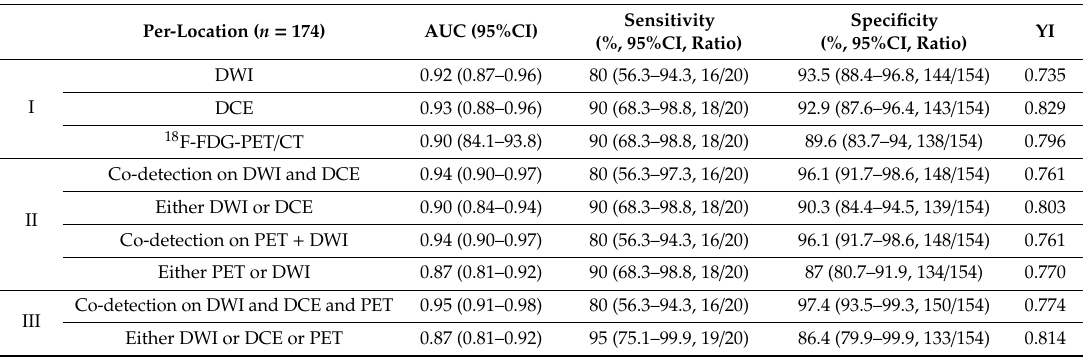
Table 3. The per-location diagnostic accuracy of (I) single use of DWI, DCE or 18 F-FDG-PET / CT and (II) the combined use of DWI + DCE and separately PET + DWI; of which the first line comprised a co-detection on both imaging modalities rated positively for malignancy. The second line comprised an independent detection on DWI or DCE and separately PET + DWI, in which either one was rated positively. (III) The combination of DWI + DCE + PET; in which the first line comprised a co-detection on all DWI + DCE + PET rated positively for malignancy. The second line comprised an independent detection on DWI, DCE or PET, in which either one was rated positive.